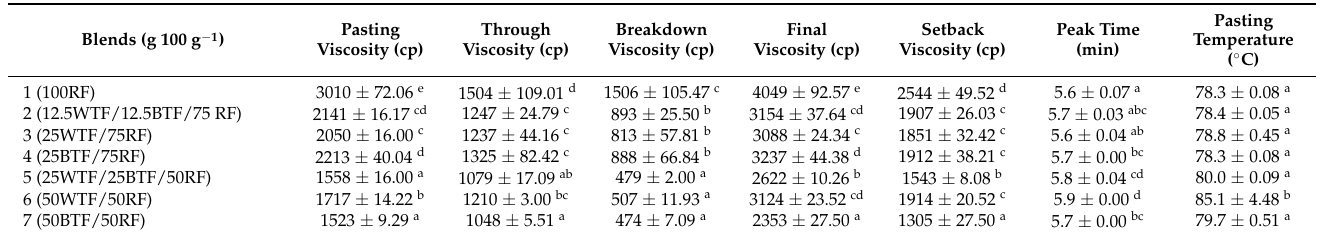
Table 7. Pasting properties of native blend flours (M1–M7).